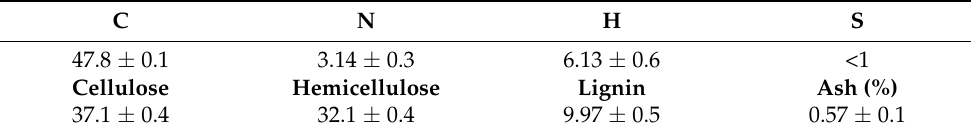
Table 2. Chemical composition (%) of CC after degreasing process.